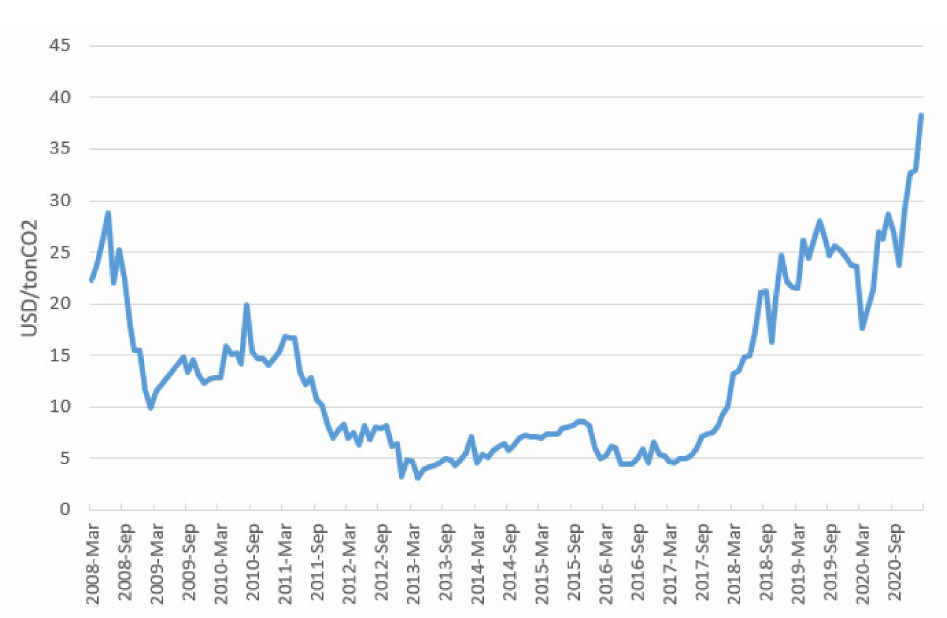
Figure 2. Historical price of carbon emission